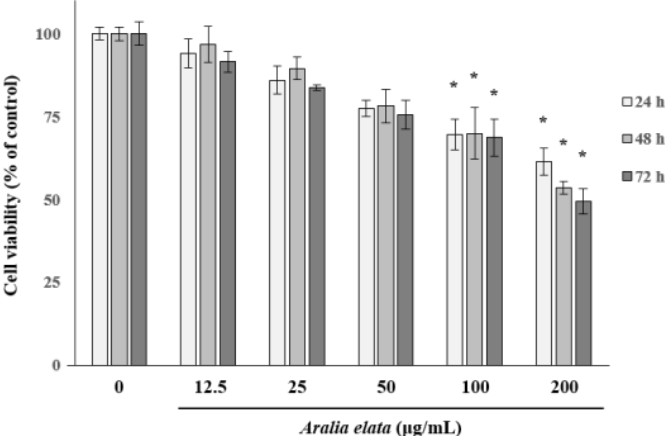
Figure 1. Effects of Aralia elata (Miq.) Seem (AS) on HUVEC viability. HUVECs were treated with AS (0 –200 μg/mL) for 72 h. Cell viability is expressed as a percentage of viable cells cultured in the absence of AS and expressed as the mean ± SD. *p <